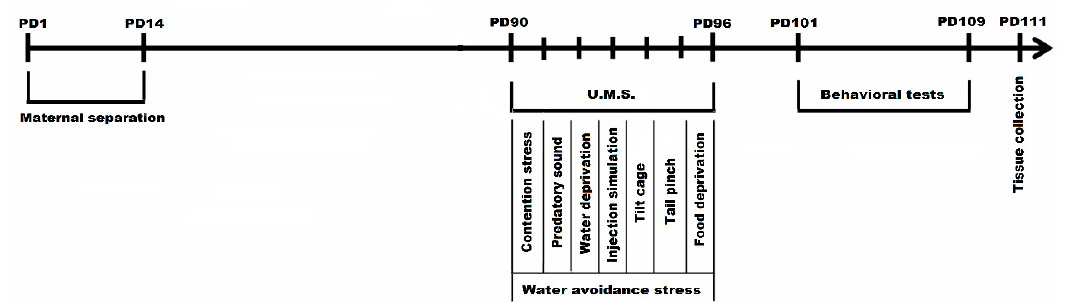
Figure 1. Experimental design of maternal separation and chronic unpredictable mild stress combination in a complex IBS mice model (PD1-PD111 = postnatal days 1-111; U.M.S = unpredictable mild stressors).